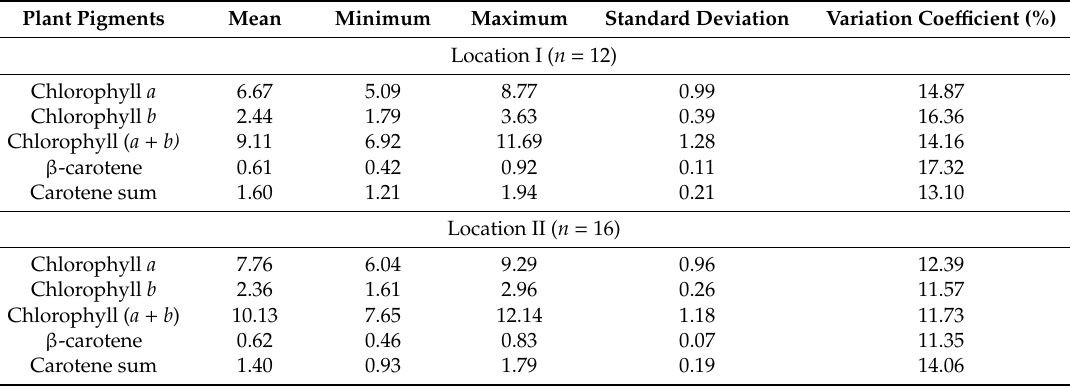
Table 4. Characteristics of the variability of chlorophyll and carotene pigments content in Melica nutans leaf blades from two forest stands (mg · g − 1